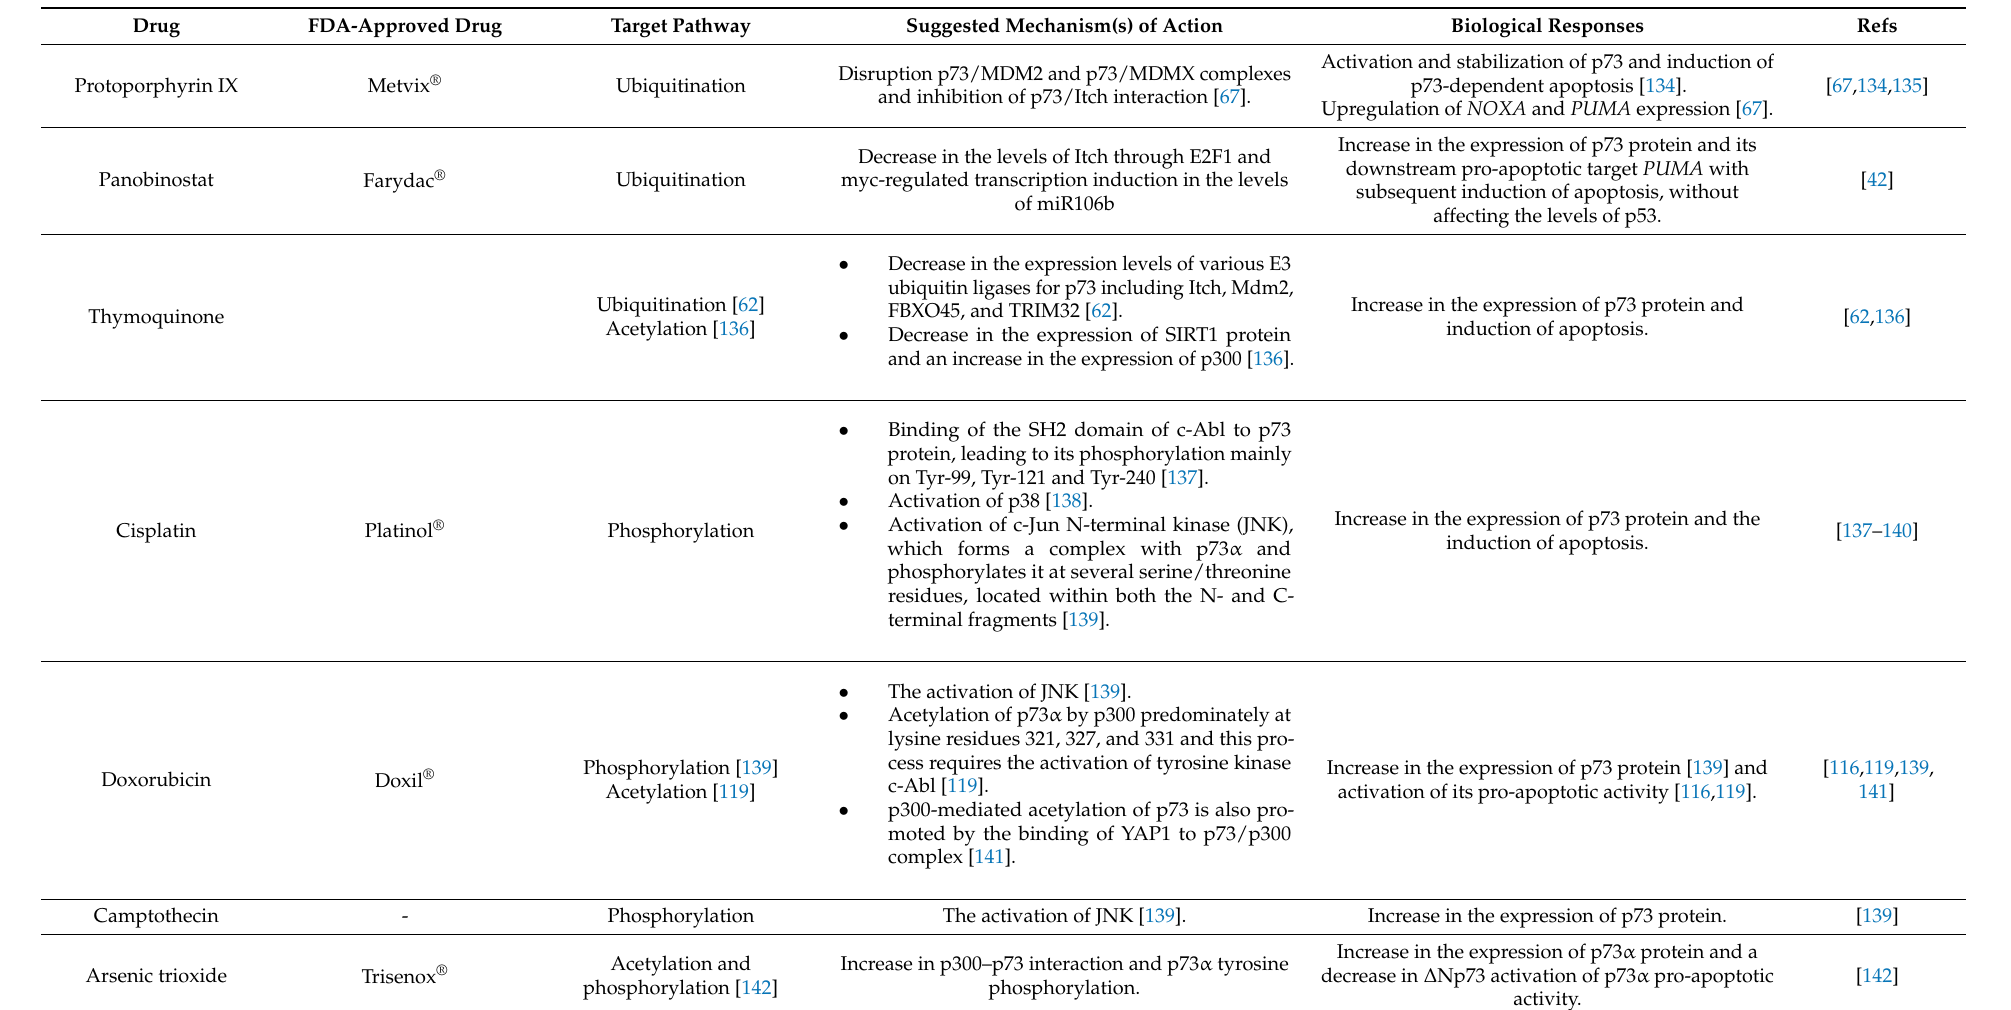
Table 3. Drugs targeting post-translational modifications of